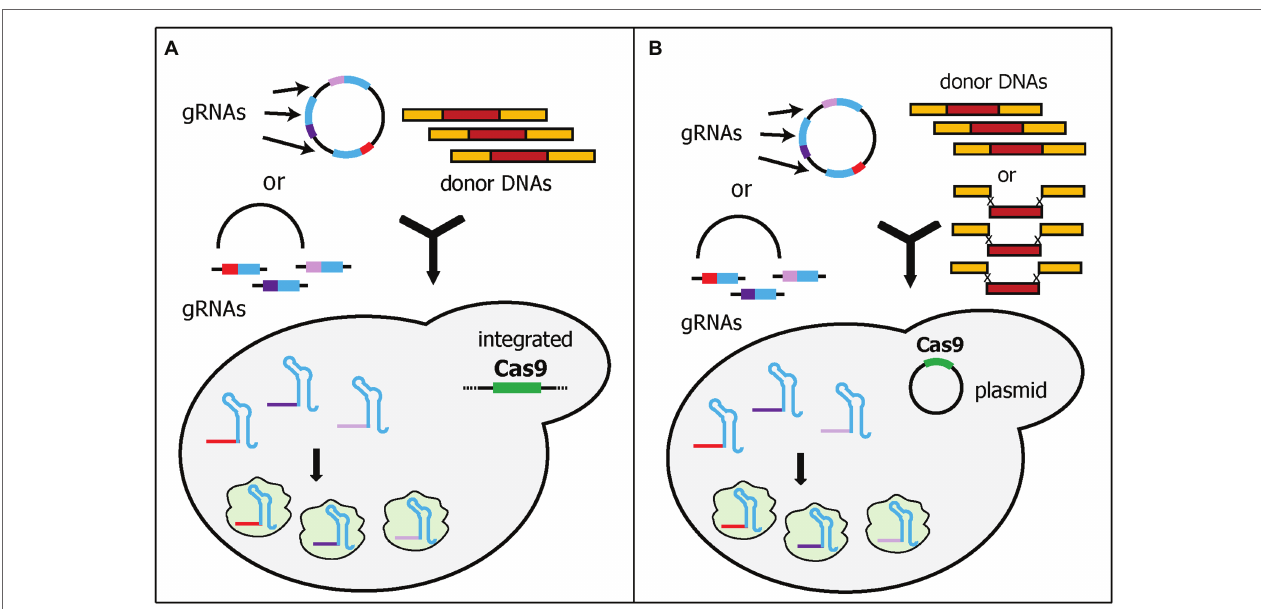
FIGURE 3 | Schematic diagram of multiplex gene editing using multi-cassette gRNA expression. Each gRNA is expressed in one cassette. The gRNA plasmid can be pre-assembled or transformed as linear fragments. The linear fragments can be assembled in vivo by yeast endogenous homologous recombination. (A) Cas9 was integrated into the genome to reduce the amount of DNA to be transformed during transformation. (B) Cas9 plasmid was pre-transformed into the yeast cells. The studies also demonstrated that donor DNAs can be transformed as separate parts rather than pre-assembled donor